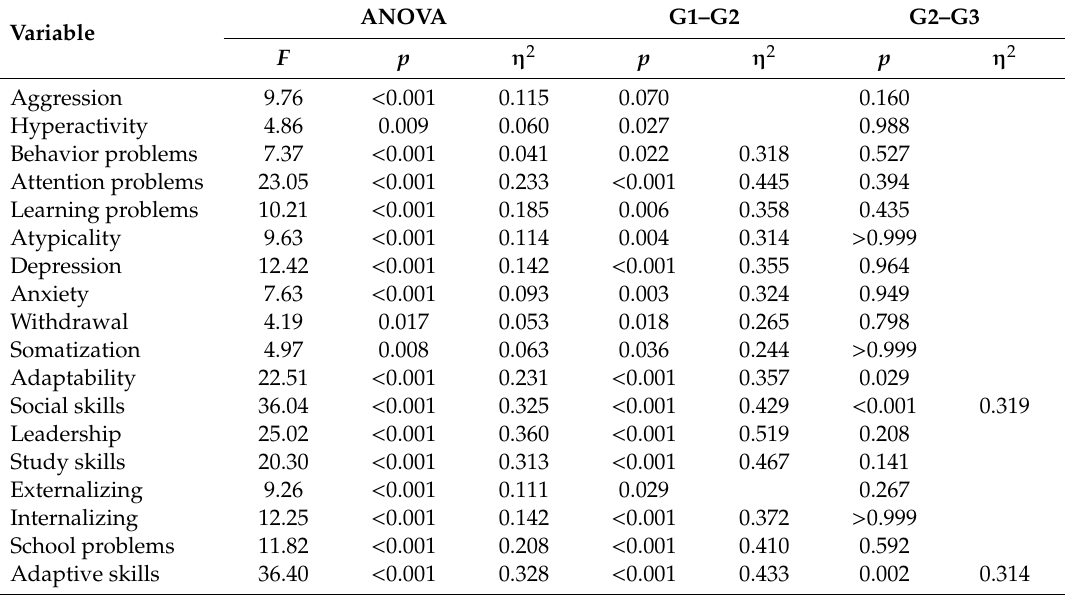
Table 1. Results of ANOVA, e ff ect size, and post-hoc